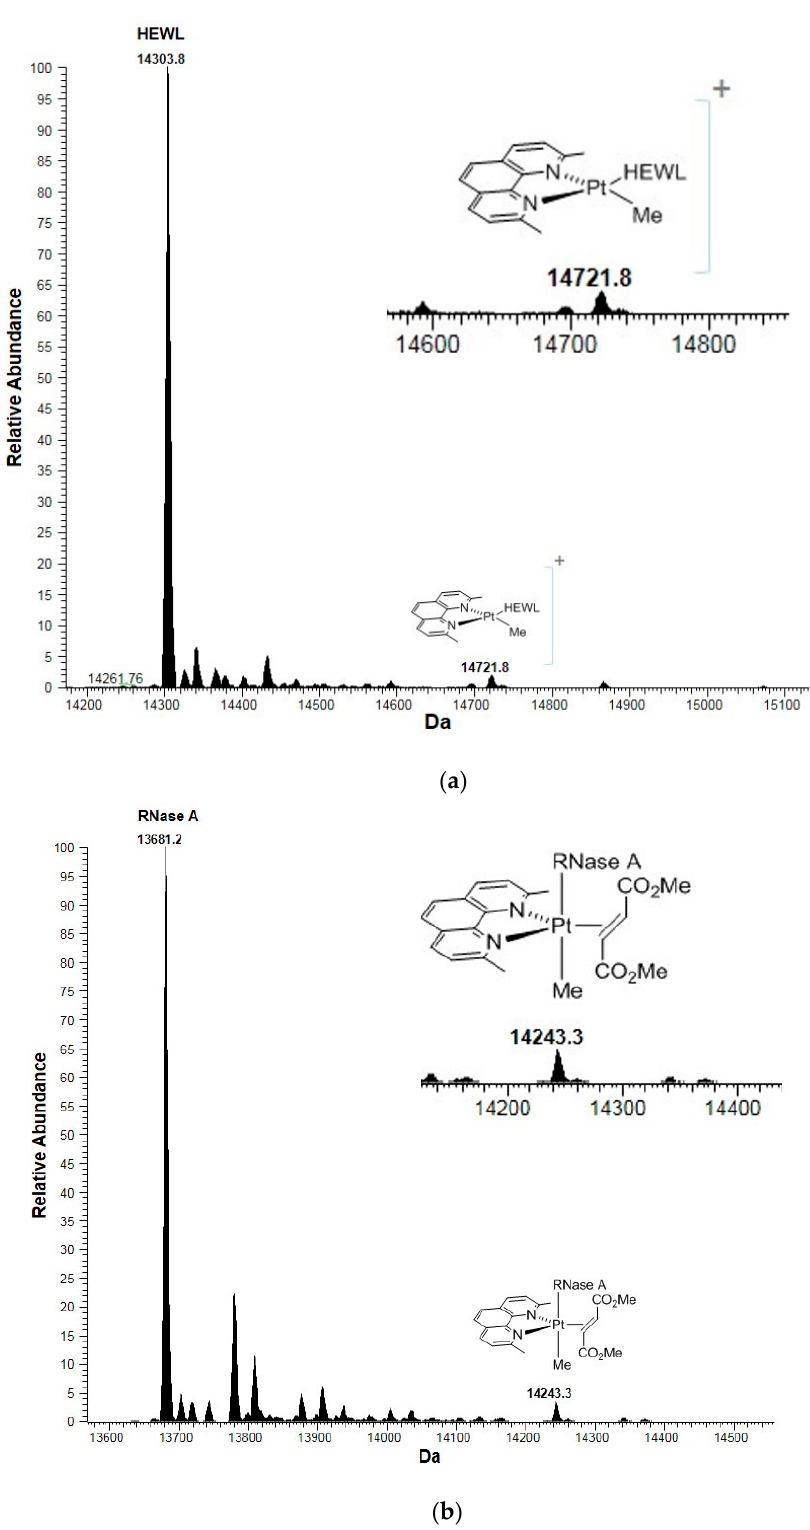
Figure 6. Deconvoluted ESI MS of HEWL (a) and RNase A (b) treated with 10 − 4 mol L − 1 complex I (metal–protein ratio = 3:1) in 20 mmol L − 1 ammonium acetate buffer, pH 7.0) recorded after 72 h of incubation at room temperature.